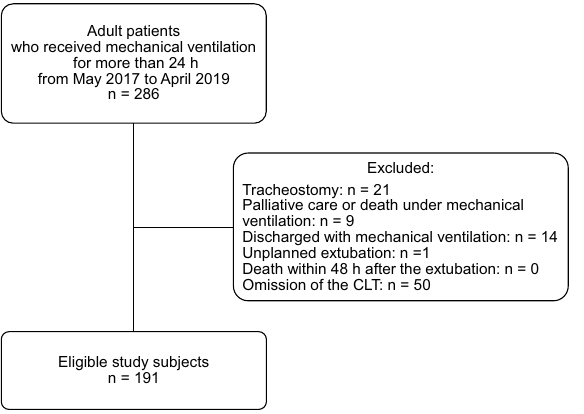
Figure 1. Flowchart of the study patients. CLT cuff leak